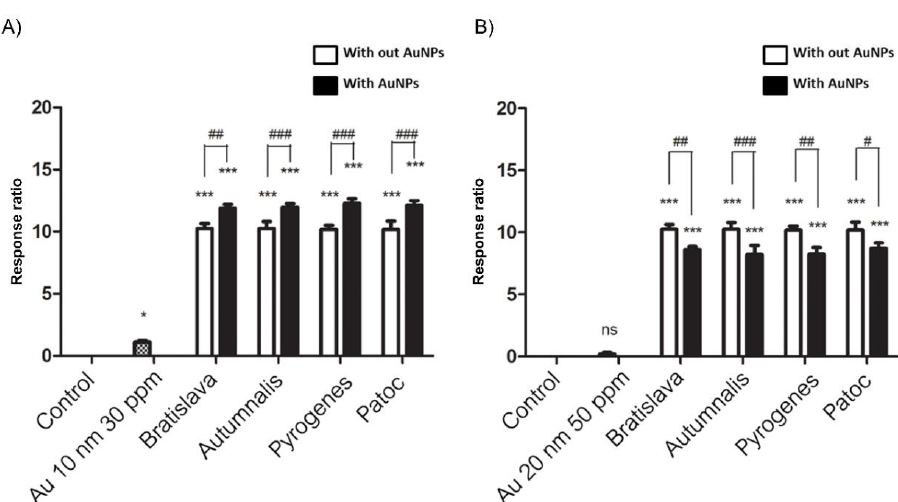
Figure 6. E ff ect of the ( A ) 10 nm (30 ppm) and ( B ) 20 nm (50 ppm) AuNPs on TLR activation with or without the presence of the di ff erent Leptospira serovars in HEK-Blue-hTLR2 cells. The levels of NF-kB-induced SEAP were determined by reading the OD at 655 nm and are relative (%) to that in the control group. Data are shown as the mean ± SD ( n = 6). Significance of the di ff erence compared to the control group is shown as * and *** for p < 0.05 and p < 0.001, respectively, and between with and without the presence of AuNPs as #, ## and ###,